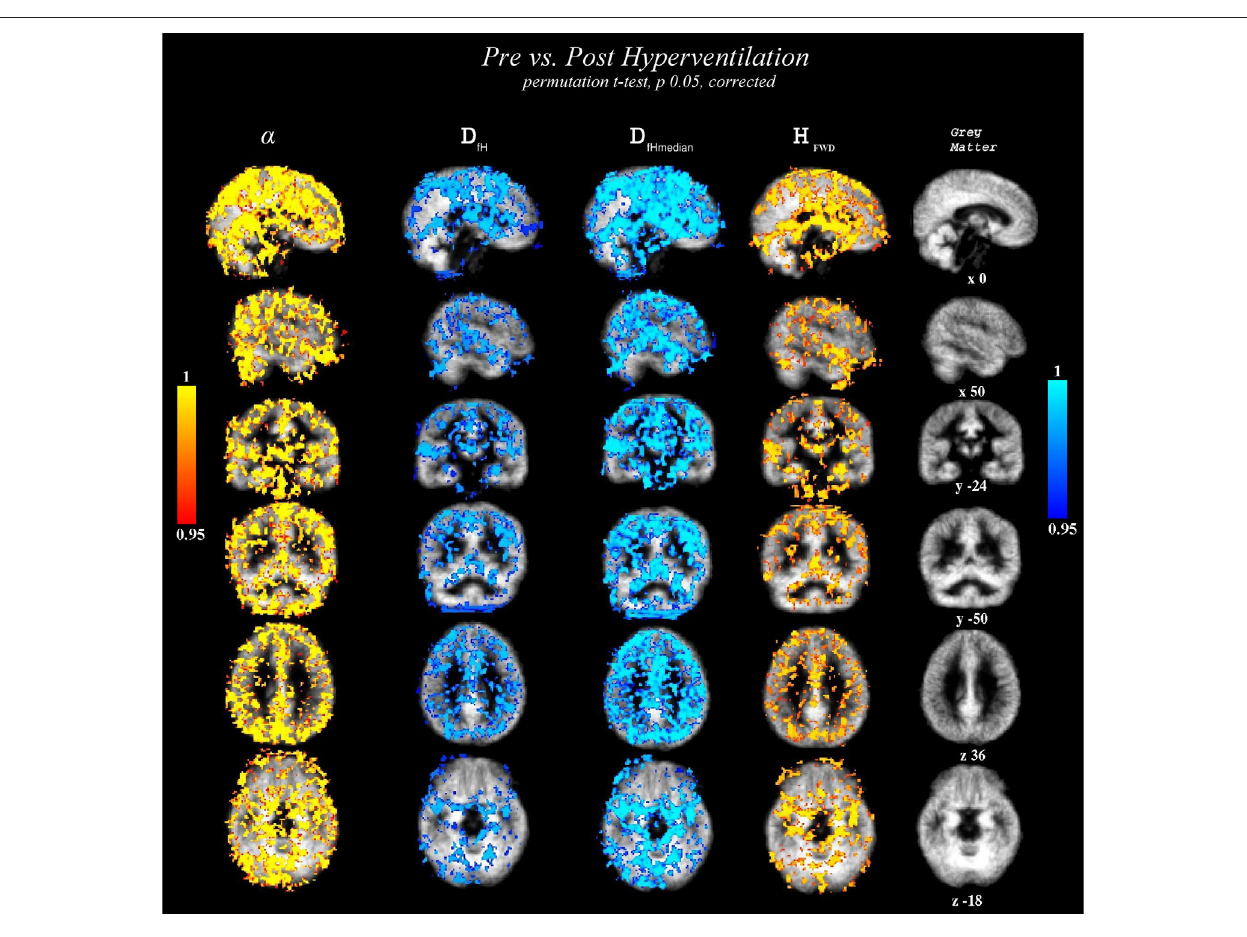
FIGURE 4 | Statistically signifi cant variable changes (between the state of normal ventilation ( Pre ) and the hyperventilation modulated state ( Post ) (2-sample paired TFCE corrected permutation test, p < 0.05). The detected voxels are overlaid on the group level mean GM segment in